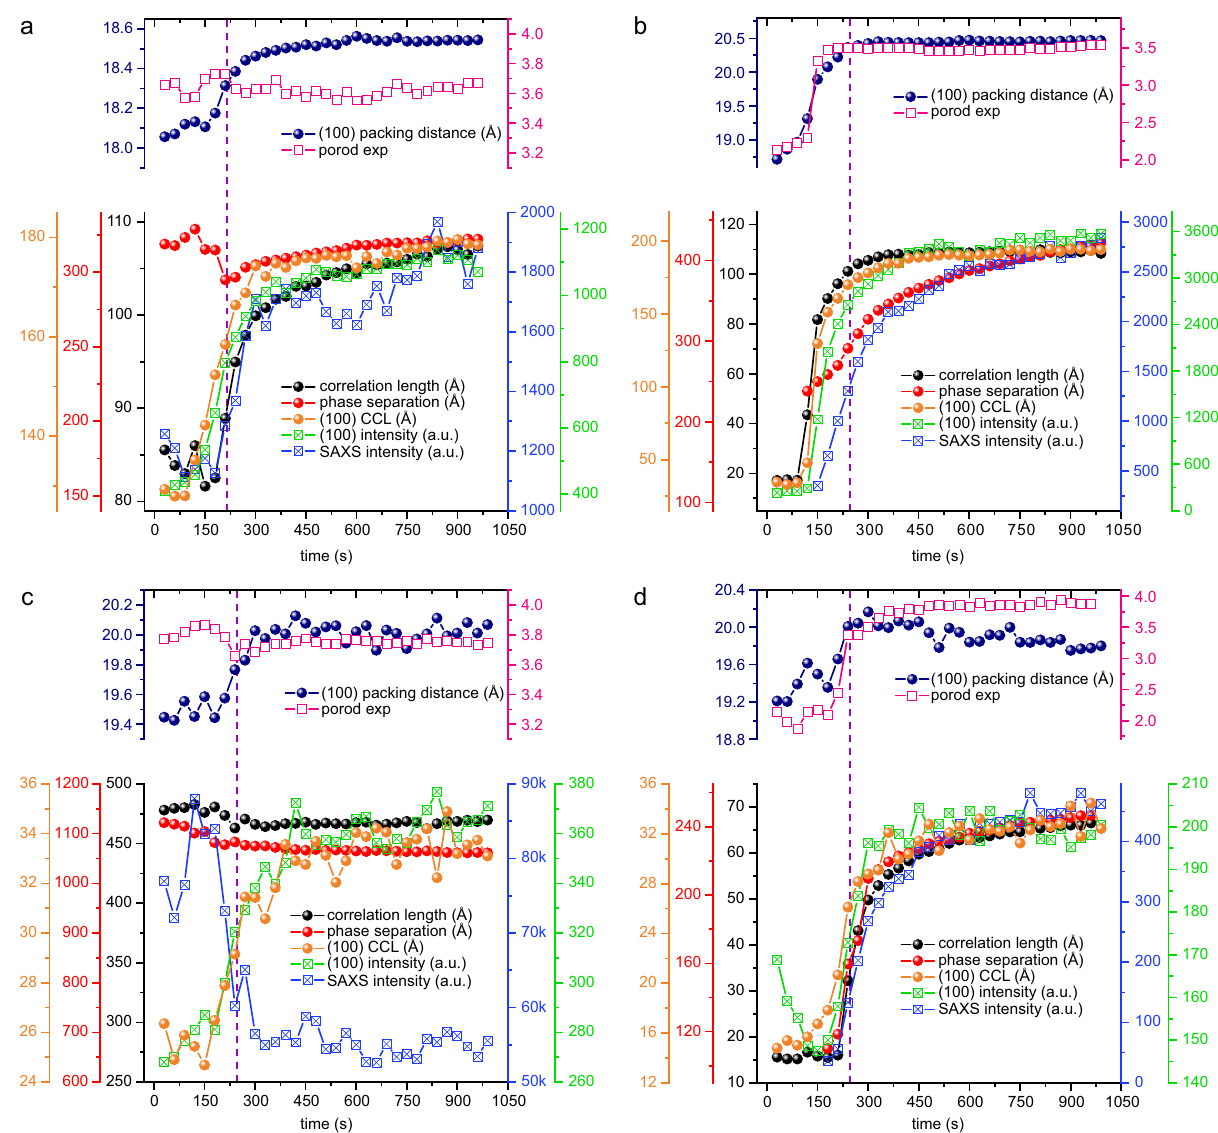
Fig. 3 Fitting results of morphology parameters extracted from in situ GISAXS/GIWAXS pro fi les. a DR3TSBDT:PC 71 BM, b DTS(PTTh 2 ) 2 :PC 71 BM, c DPPEZnP-TEH:PC 61 BM, and d DPPEZnP-TEH:PC 61 BM/Py (purple dashed line is used to separating heating stage from annealing